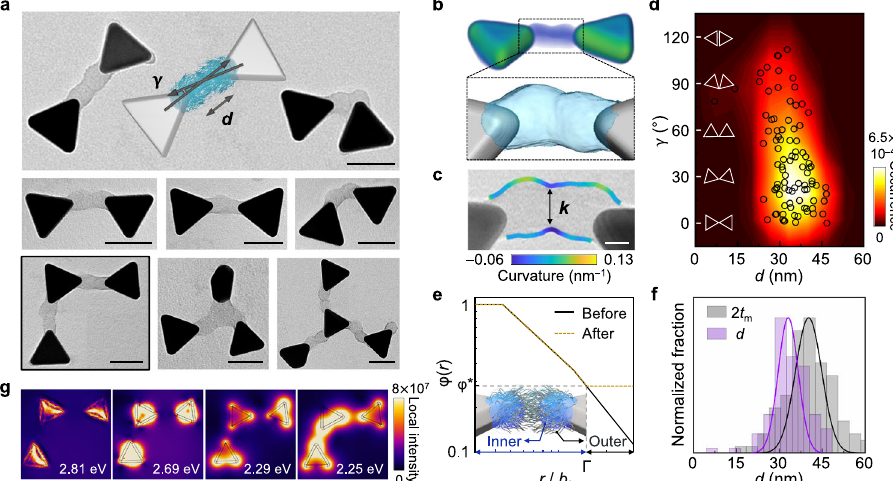
Fig. 4 | Self-limited assembly of single-patch prisms by patch ‒ patch inter- penetration. a TEMimagesof nano-bowties,trimers,and tetramersexhibitingtip- to-tip connection. Schematics of a nano-bowtie labeled with interparticle angle γ and tip-to-tip distance d (inset). b TEM tomograph of a nano-bowtie and 3D reconstruction of merged patches. c Curvature analysis of merged patches. d Heatmapof γ and d bythekerneldensityestimationoverlaidwiththescatterplot obtained from experiment: γ =39.9±30.4°, d =33.6±6.7nm. e Theoretically cal- culatedmonomerdensitypro fi les φ ð r Þ before(blackline)and after merging (black linewithagreenshadow)asafunctionofthedistanceawayfromatip r normalized by Kuhn monomer size b l at interparticle angle γ of 0°. Inset: schematics of the theoretical model of patch ‒ patch interpenetration. The crossover distance Г